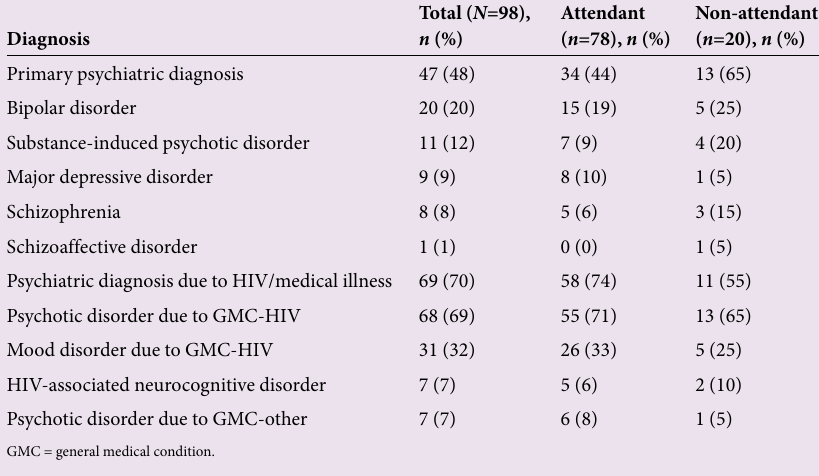
Table 2. Outline of attendant v. non-attendant groups by psychiatric